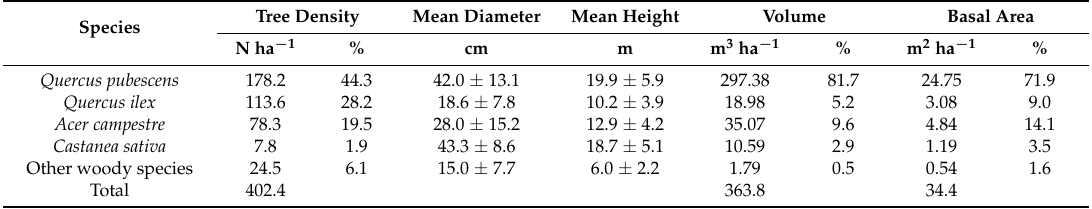
Table 2. Density, diameter, height, volume and basal area of the woody species surveyed.